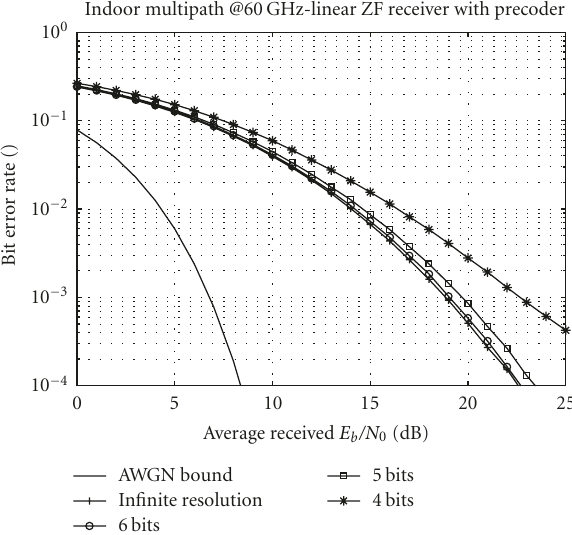
Figure 13: Impact of phase noise on the BER performance of CPM.